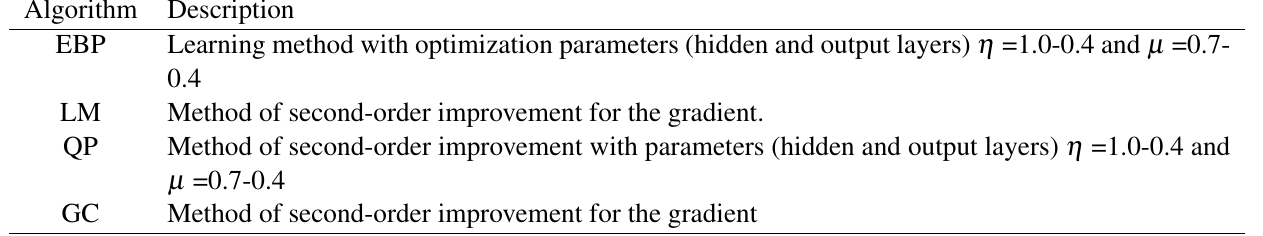
Table 10: Stage 4. List of learning algorithms studied